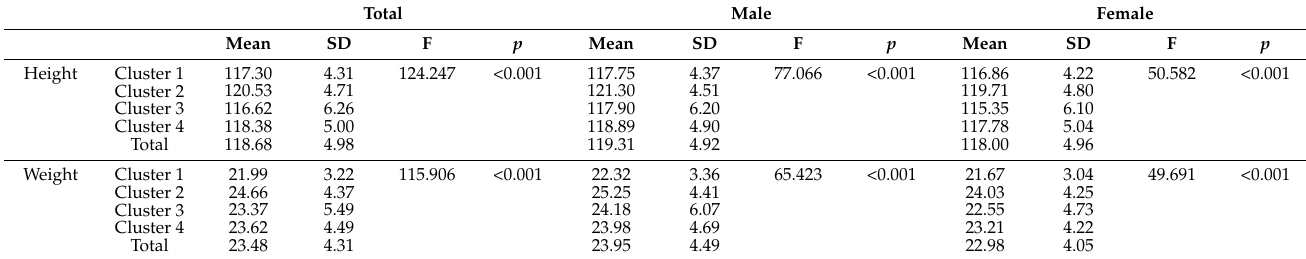
Table 3. Distributional analysis of physique (height, weight) by physical fitness clusters.